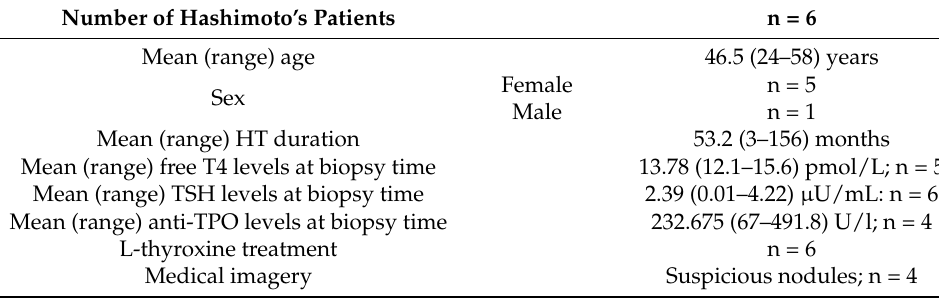
Table 1. Characteristics of Hashimoto’s